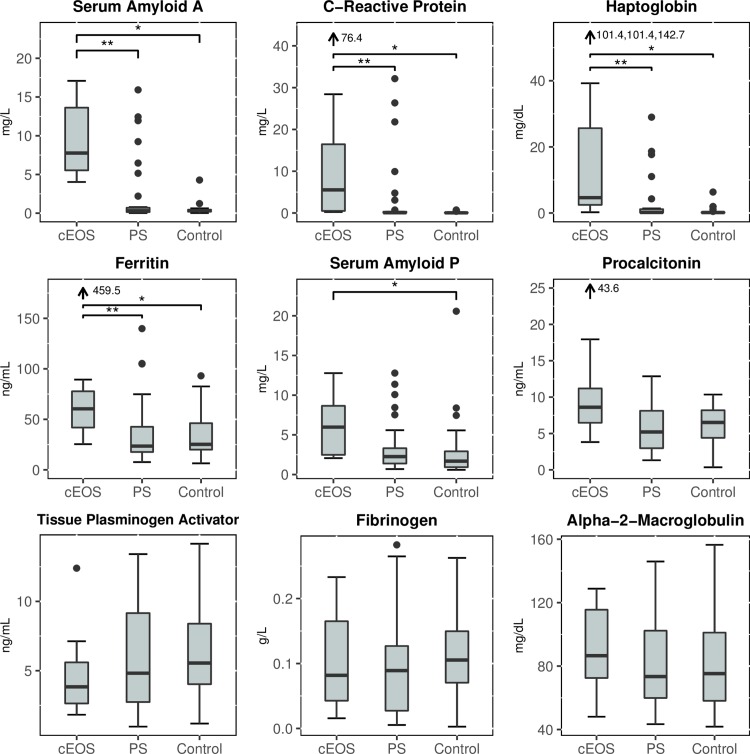
Acute phase reactant levels in sepsis groups.Box and whisker plots displaying distribution of 9 APR biomarkers (SAA, CRP, Hp, ferritin, SAP, PCT, tissue plasminogen activator, fibrinogen, α-2-macroglobulin) in each sepsis category. *Indicates significant difference in APR values between cEOS and control groups. **Indicates significant difference in APR values between cEOS and PS groups.